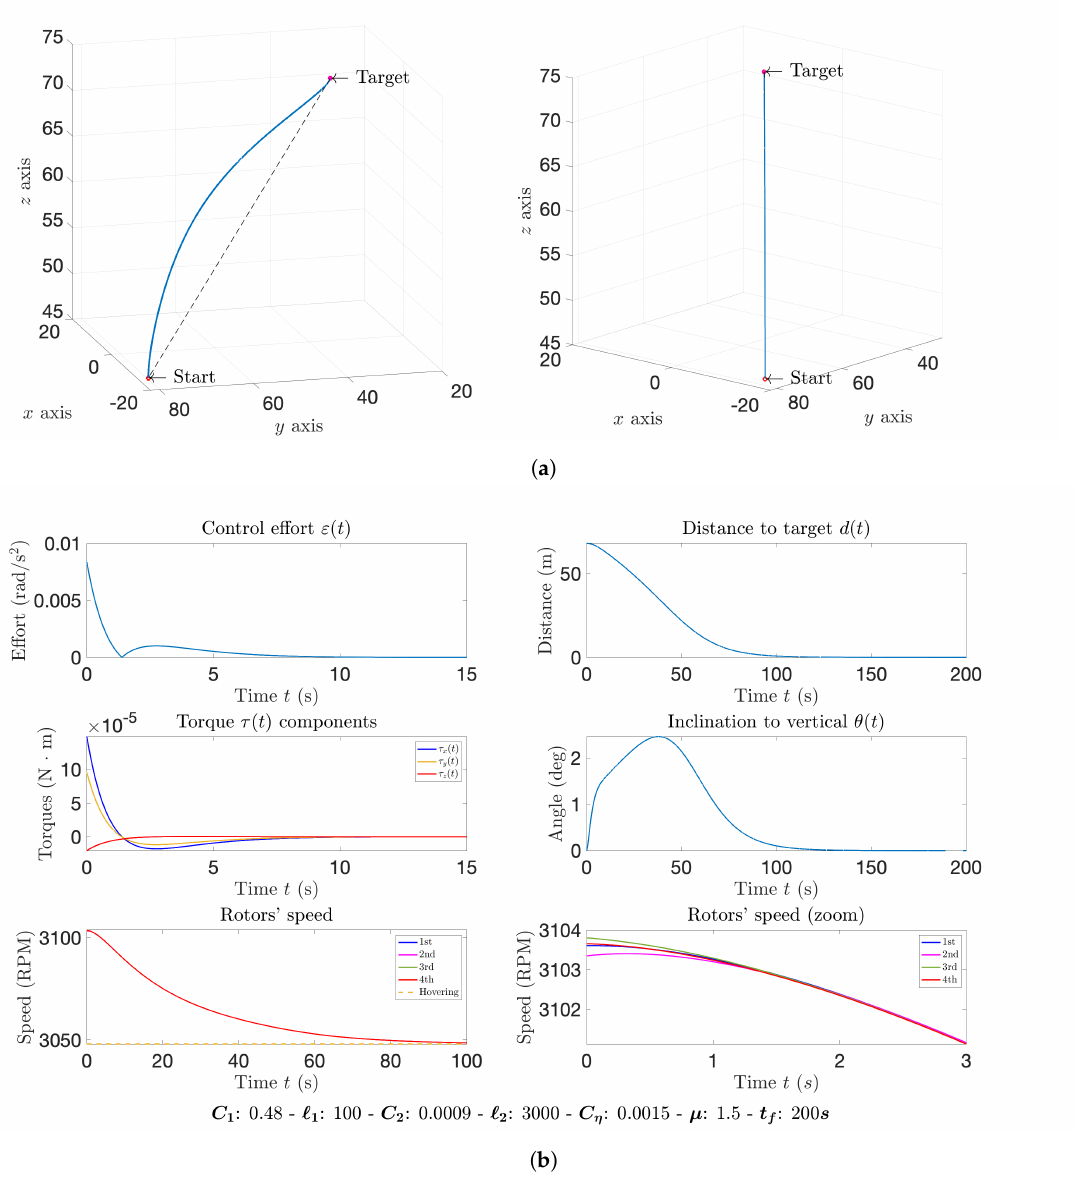
Figure 2. Experiment: Target point above the start point, favorable initial conditions. In the RPM panel, the yellow dashed line represents the steady-state hovering speed value (RPM ss = 3048 from [32]). Below the panels are reported the values of VARP parameters used in the simulation. Notice that different panels present different time-spans in order to better illustrate the trend of the curves during the simulation. ( a ) Target approaching trajectory; ( b ) Control